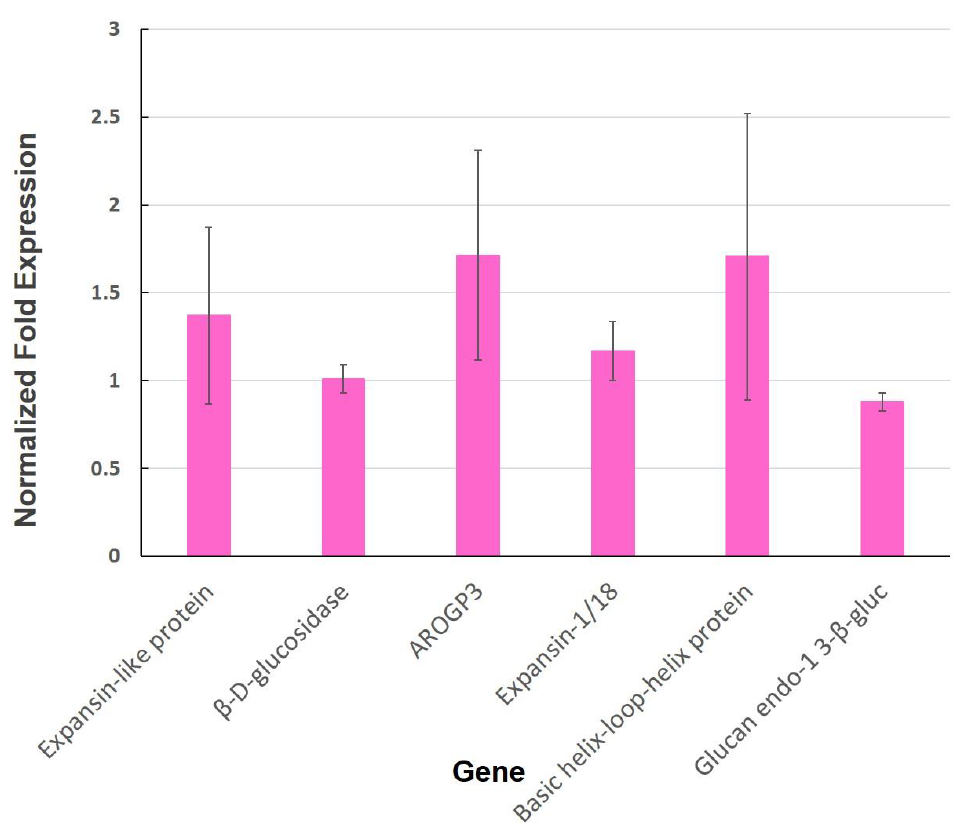
Figure A2. S. sclerotiorum infection on tomato leaves estimated by measuring the diameter of the necrotic lesion on MYC and CTR plants at 27 hpi (hours post-infection).